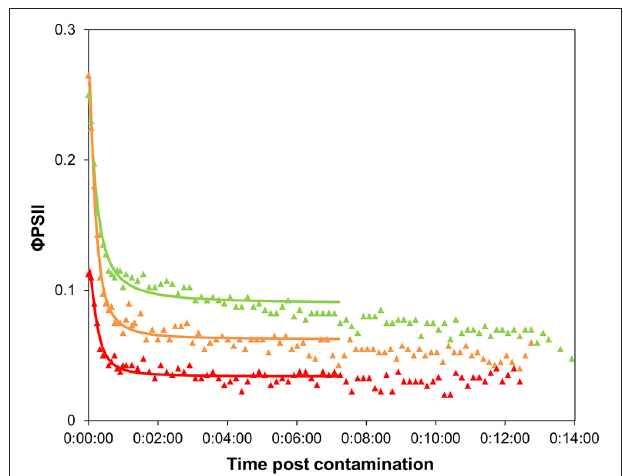
FIGURE 5 | Time-response curves based on ϕ PSII decrease for biofilms pre-exposed to 3-h diuron pulses, after contamination at “high” concentration (Experiment 2). Values are average of 4 replicates. Pulse concentration: 0.3 µ g.L − 1 : green triangles, 19.1 µ g.L − 1 : orange triangles, 102.4 µ g.L − 1 : red